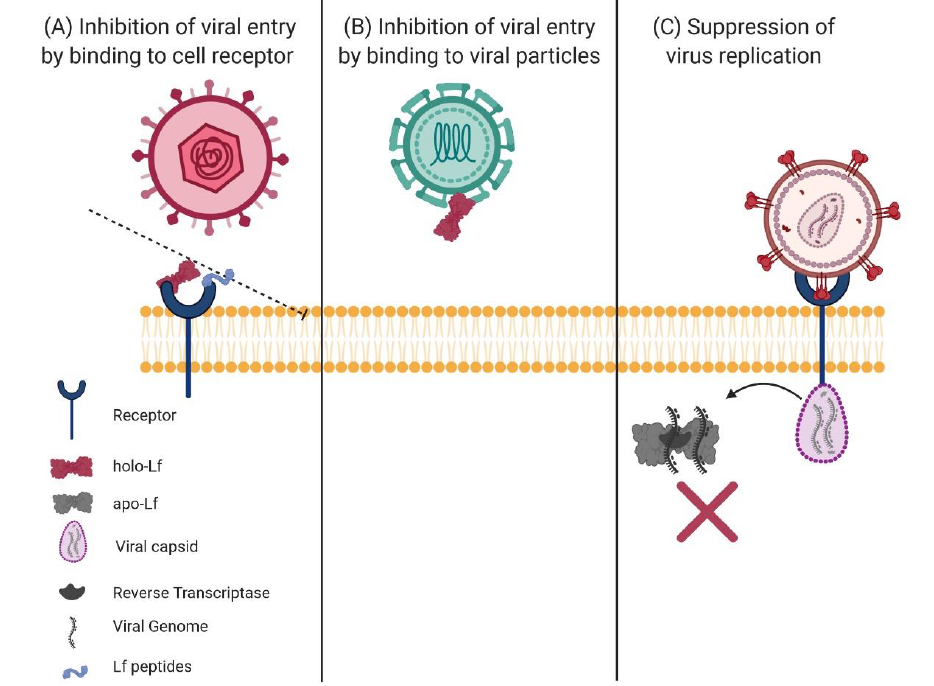
Figure 5. Mechanisms of the antiviral action of lactoferrin (Lf) and lactoferricins (Lfcins). ( A ) Inhibition of viral entry by binding to cell receptors: binding to some molecular components rather than making up cell receptors prevents viral infection and prevents viral adsorption and replication. ( B ) Inhibition of viral entry by binding to viral particles: Lf binds to viral particles in the early stages of infection, thus blocking the entry of the virus into the cell and subsequent viral replication. ( C ) Suppression of virus replication: Lf can inhibit the replication of some viruses even after cell infection